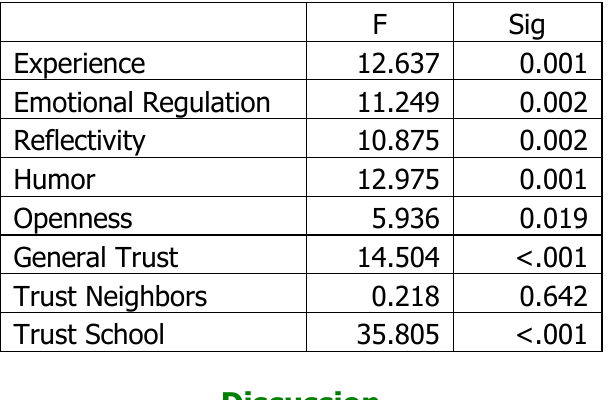
ANOVAs for Individual Wisdom Domains and Social Trust